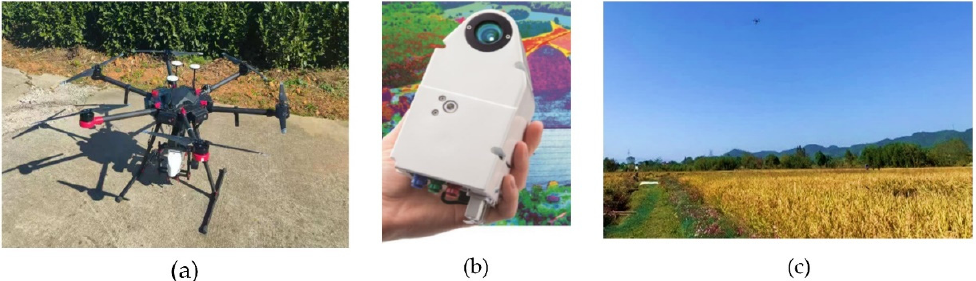
Figure 2. UAV image acquisition: ( a ) UAV platform, ( b ) Multispectral Rikola Camera, and ( c ) UAV flight experiments.